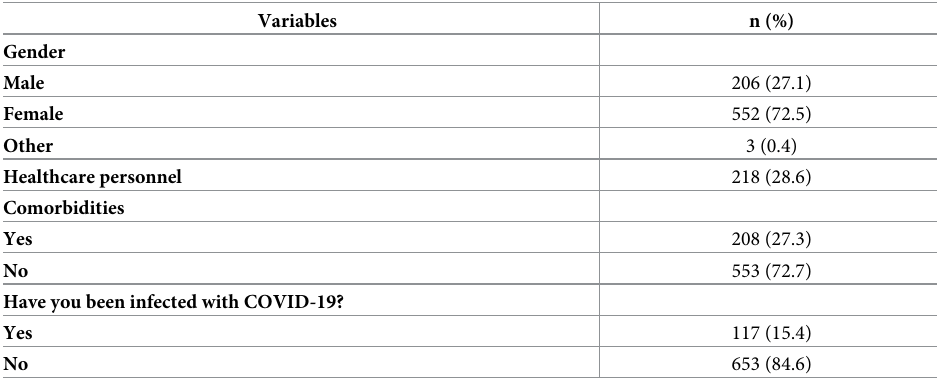
Table 1. Demographic characteristics of the